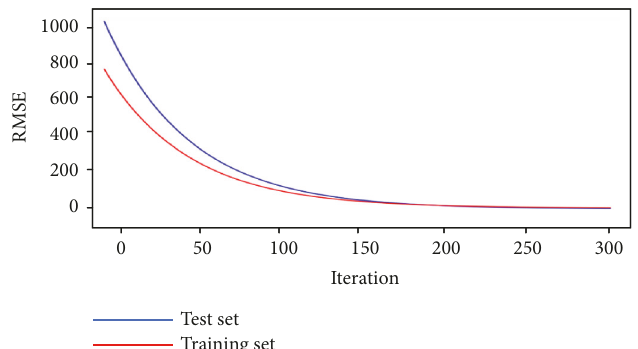
Figure 5: Results of model training.